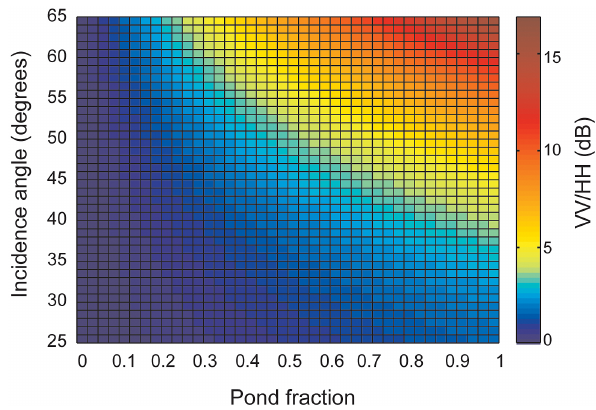
Figure 3. Illustration of Cscat modelled VV / HH in dB as a function of incidence angle and pond